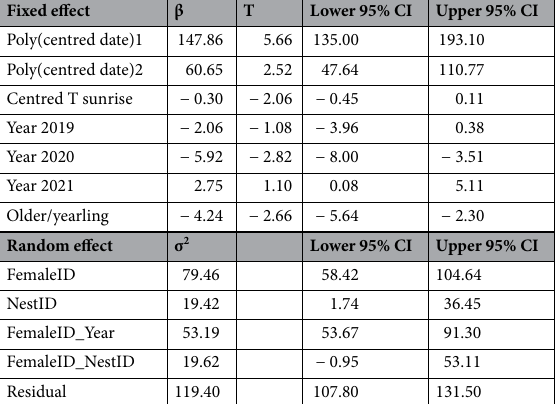
Table 3. Results from linear mixed effects model with emergence time (in minutes relative to sunrise) as response variable. Date and temperature (T) at sunrise were mean-centred within years. 95% confidence intervals are calculated with parametric